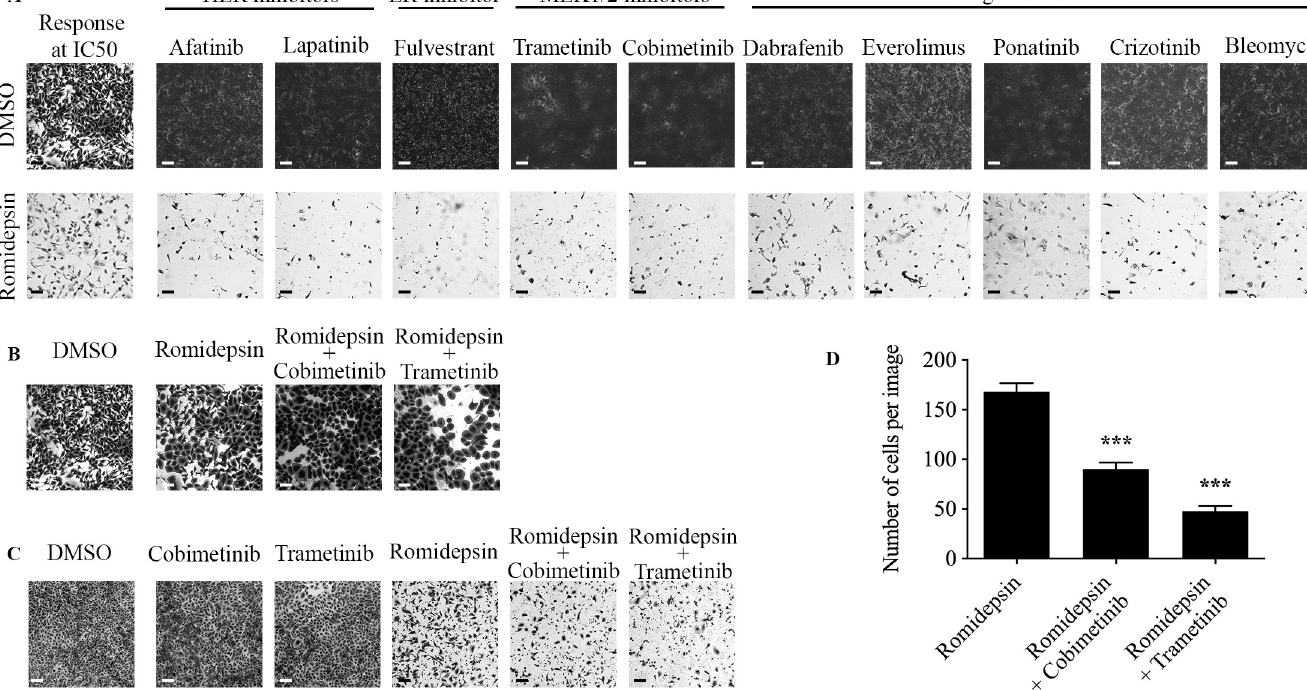
PLOS ONE | https://doi.org/10.1371/journal.pone.0226464 October 9,